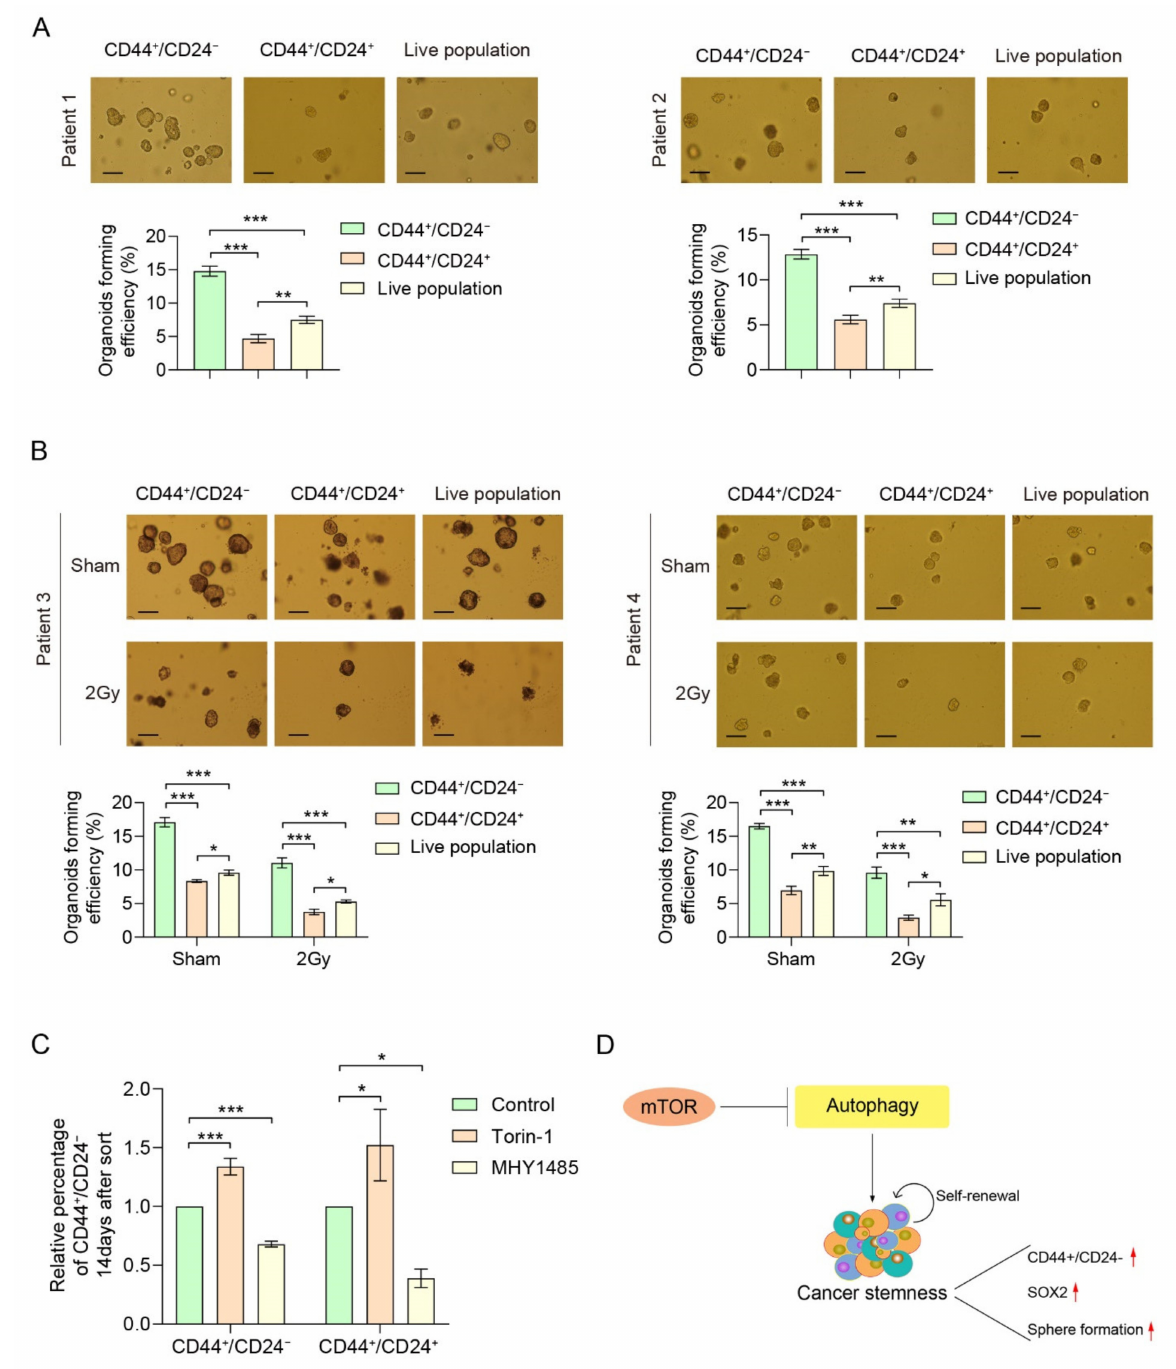
Figure 6. CD44 + /CD24 − represents a CSC population and can be modulated by the mTOR pathway. ( A , B ) CD44 + /CD24 − population forms more organoids compared to CD44 + /CD24 + or CD44 − /CD24 − populations and are more radiation-resistant upon 2 Gy radi- ation. Scale bar = 100 µ m. ( C ) Both CD44 + /CD24 − and CD44 + /CD24 + -sorted cells treated with Torin-1 (10 nM, 14 days) showed an increased CD44 + /CD24 − phenotype compared to DMSO controls whereas the same sorted populations show a more pronounced decrease in CD44 + /CD24 − cells with MHY1485 (1 µ M, 14 days). ( D ) Schematic representation of the role of mTOR in esophageal cancer stemness through autophagy. Error bars indicate SD. * p < 0.05, ** p < 0.01 and *** p < 0.001 by two-way ANOVA followed by a Tukey–Kramer post hoc